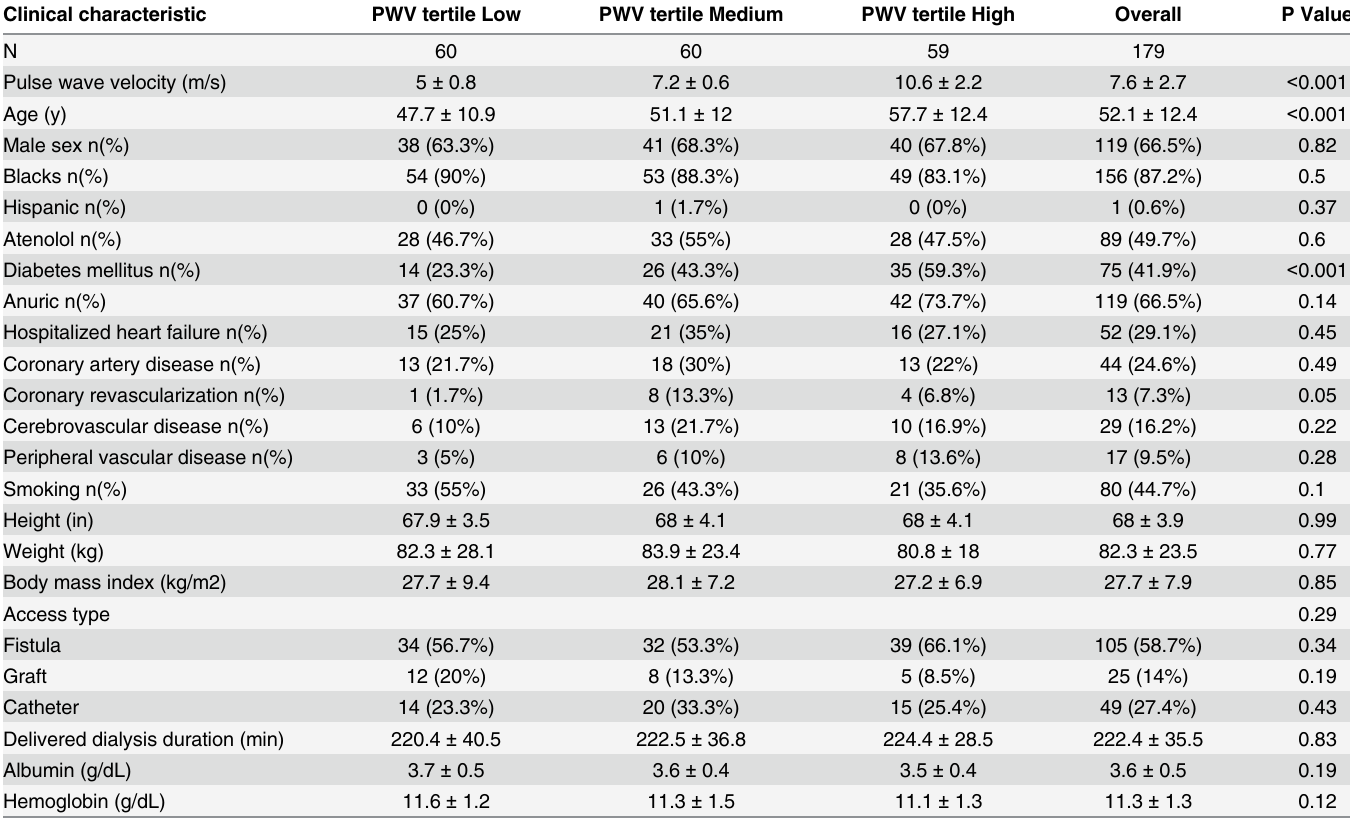
Table 1. Baseline characteristics of study participants according to the tertile of baseline aortic pulse wave velocity. Clinical